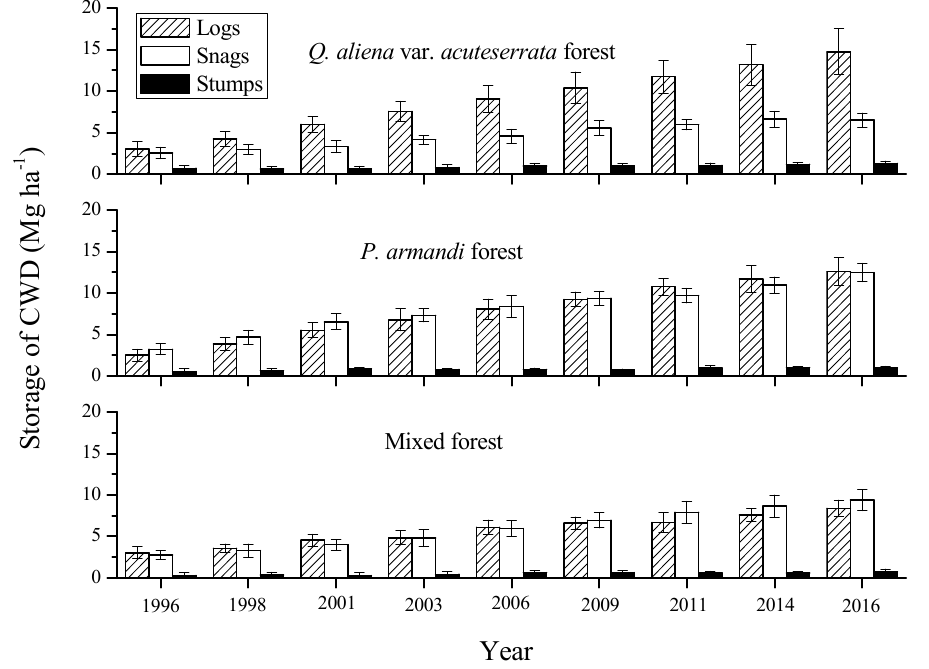
Figure 4. Mass of CWD compositions (logs, snags, and stumps) at the nine tree censuses during 1996–2016 for the three forest types in the Huoditang Experimental Forest Farm in the Qinling Mountains (China). The error bars represent the standard error of the mean, and are based on the plot as the experimental unit ( n = 6).